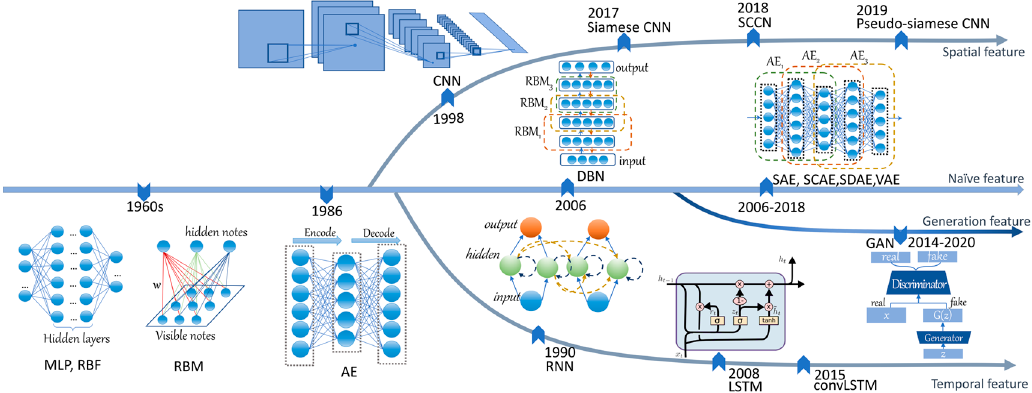
Figure 12. The development of deep neural network for change detection.